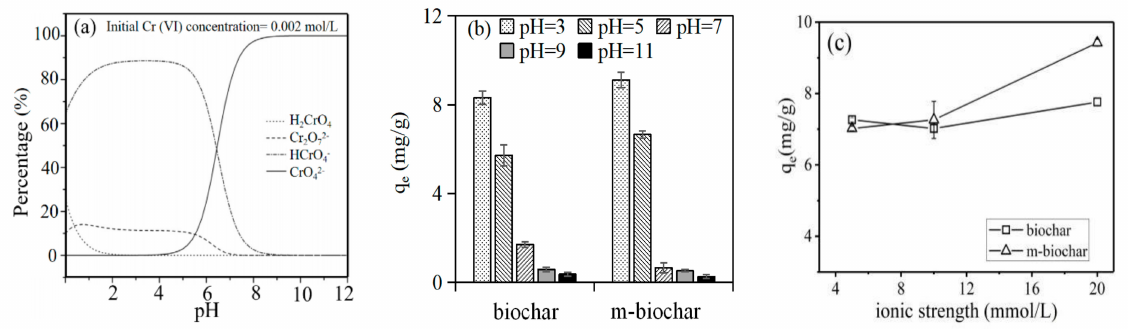
Figure 5. ( a ) The chromium ion species in the groundwater under different pH conditions (the modified figure was adapted from Zhou et al, 2016) [37] ( b ) effects of pH on Cr(VI) adsorption, and ( c ) effects of ionic strength on Cr(VI)